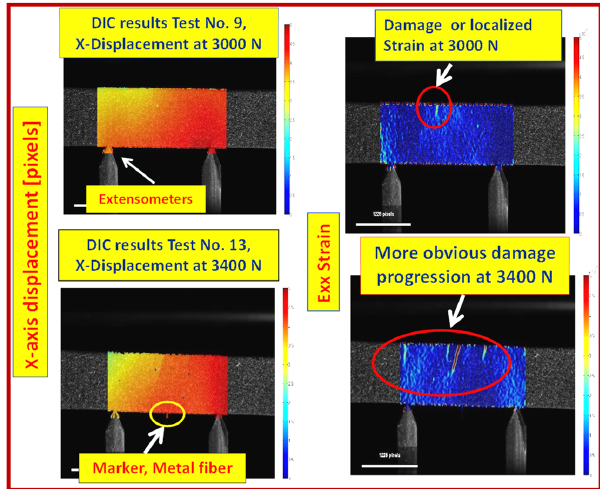
Figure 10. Plots of the displacement field (left) and the strain field (right) of the last image frame before failure. DIC: Digital image correlation.